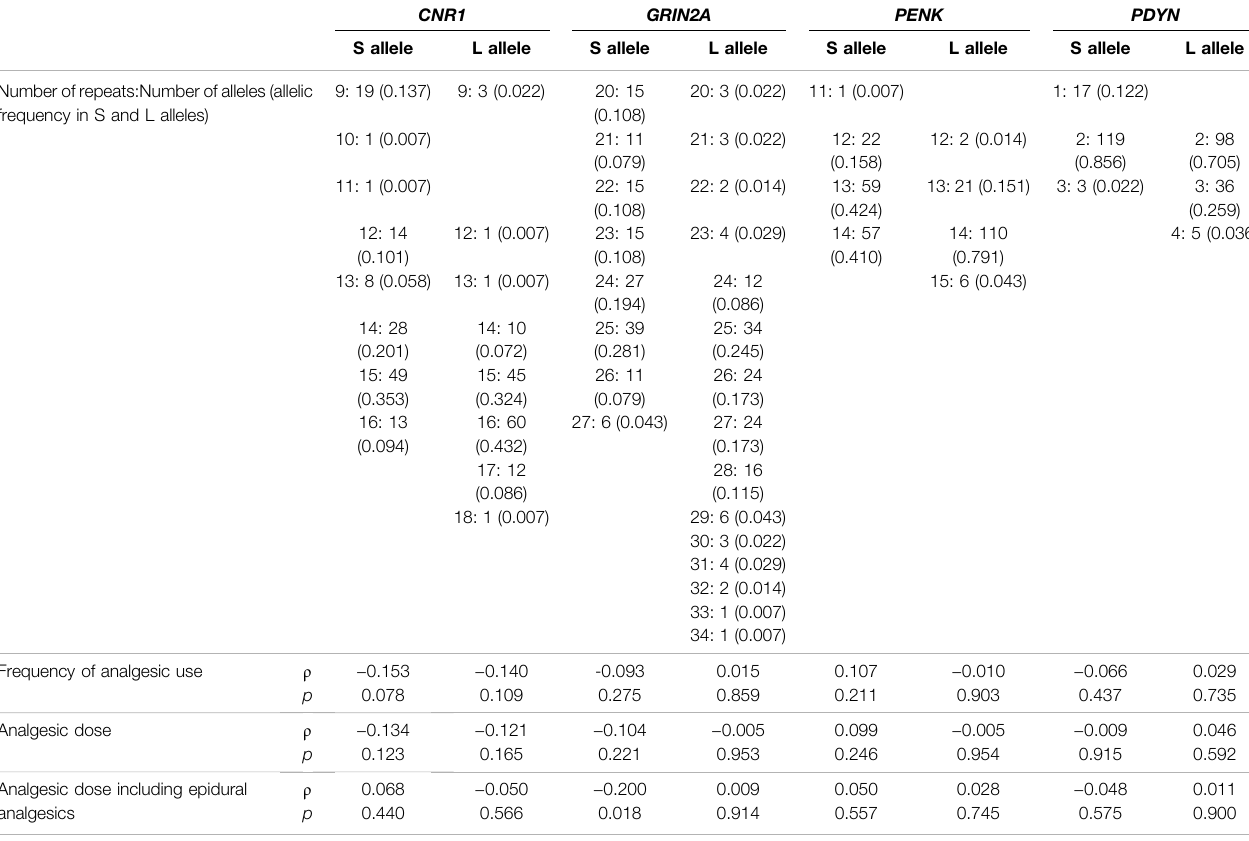
Spearman ’ srankcorrelationtestswereconductedtoexamineassociationsbetween shorter(S)and longer(L)allelesin eachSTRorVNTRandthe frequencyofanalgesicuseduringthe 24 h postoperative period (frequency of analgesic use), 24 h postoperative analgesic dose converted to systemic pentazocine (analgesic dose), and 24 h postoperative analgesic